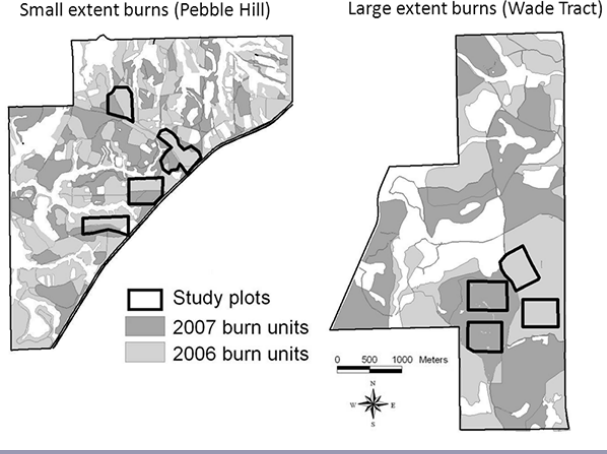
Fig. 1 . Study plots and burn units for small-extent burns and large-extent burns. Large burn units (70 - 100 ha) were located in and around the large-extent study area on the Wade Tract, and smaller burn compartments that ranged 10 - 15 ha in extent were located on Pebble Hill. Plots on the large-extent study area were either burned or not burned during the 2-yr study, whereas plots on the small-extent study area were only partially burned each